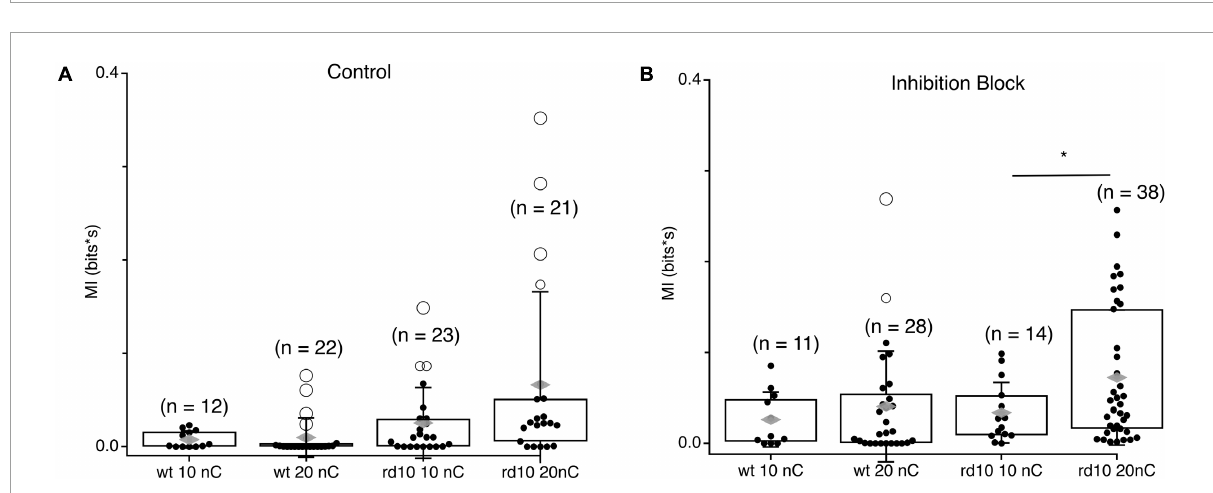
FIGURE6 Comparison of spontaneous MI between RGC pairs at different stimulation levels. (A) Box plots showing integrated MI between RGC pairs in wt and rd10 retina for spontaneous activity following 10 or 10 nC stimulation. (B) Same as panel (A) , but in inhibition block (5 µ M SR-95531, 50 µ M TPMPA, and 5 µ M strychnine). Filled black circles represent data points, open circles represent outliers, whiskers show 1 standard deviation, gray diamonds represent the mean. *Denotes p <